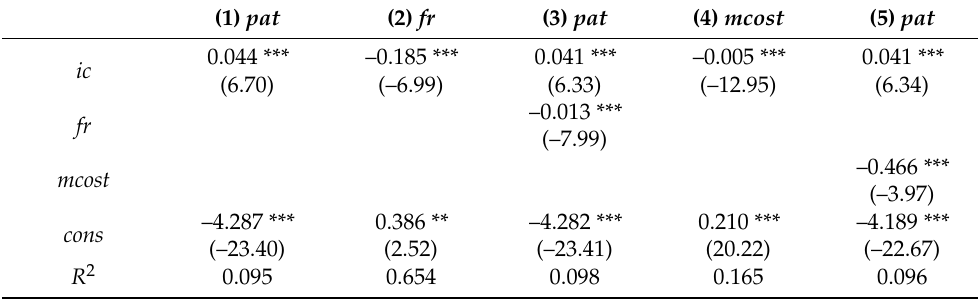
Table 5. Mechanism test results of enterprise risk and agency